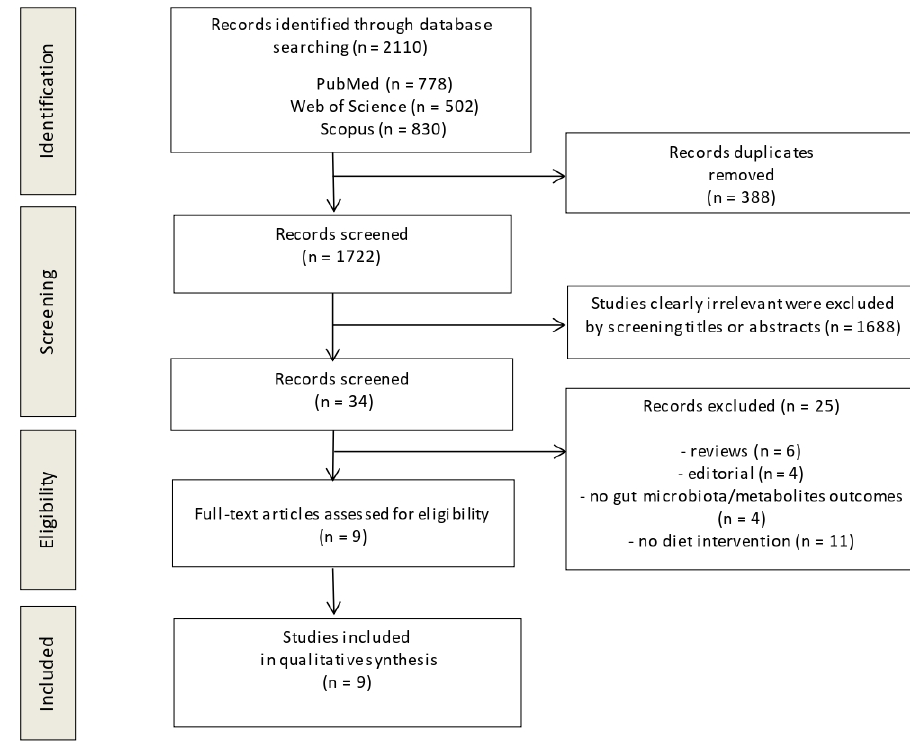
Figure 1. Preferred Reporting Items for Systematic Reviews and Meta-Analyses (PRISMA) flow di ‐ agram.